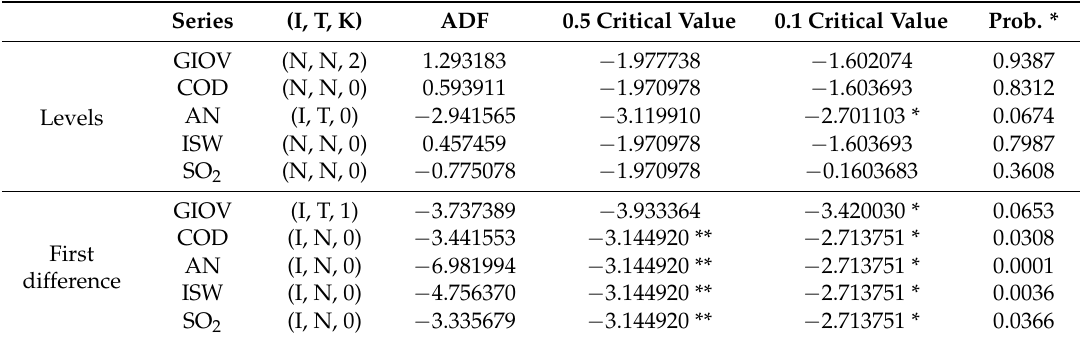
Table 4. Unit root test results for non-ferrous metal ore mining and processing.